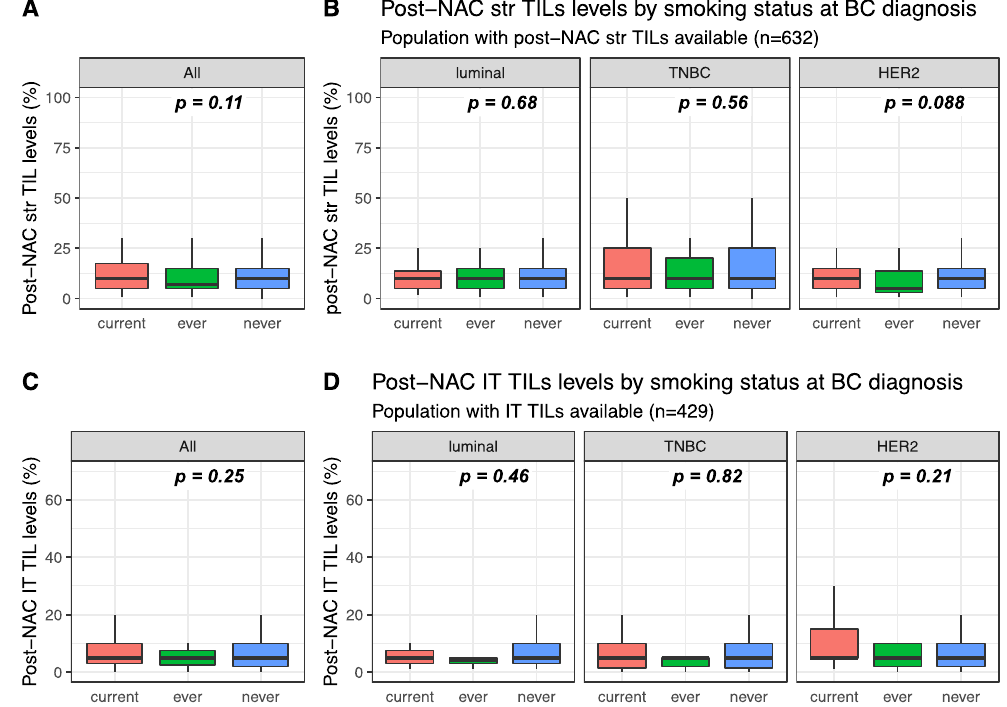
Figure 3. Post-NAC TIL levels according to smoking status: ( A ) post-NAC str TIL levels in the whole population, ( B ) post-NAC str TIL levels by BC subtype, ( C ) post-NAC IT TIL levels in the whole population, ( D ) post-NAC IT TIL levels by BC subtype.